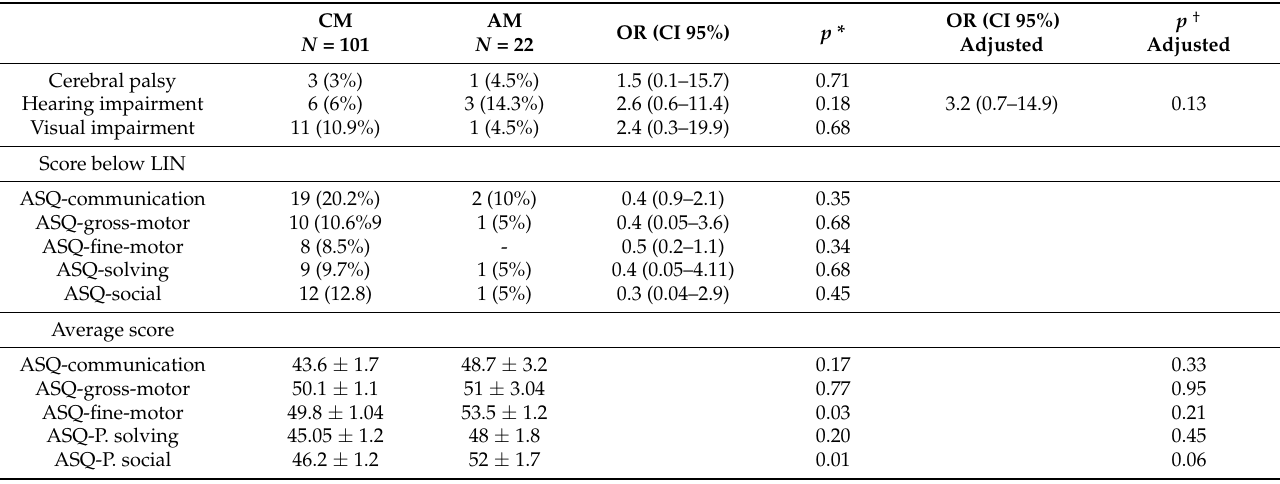
Table 4. 24 months corrected age monitoring results, according to antenatal corticosteroid regimen.